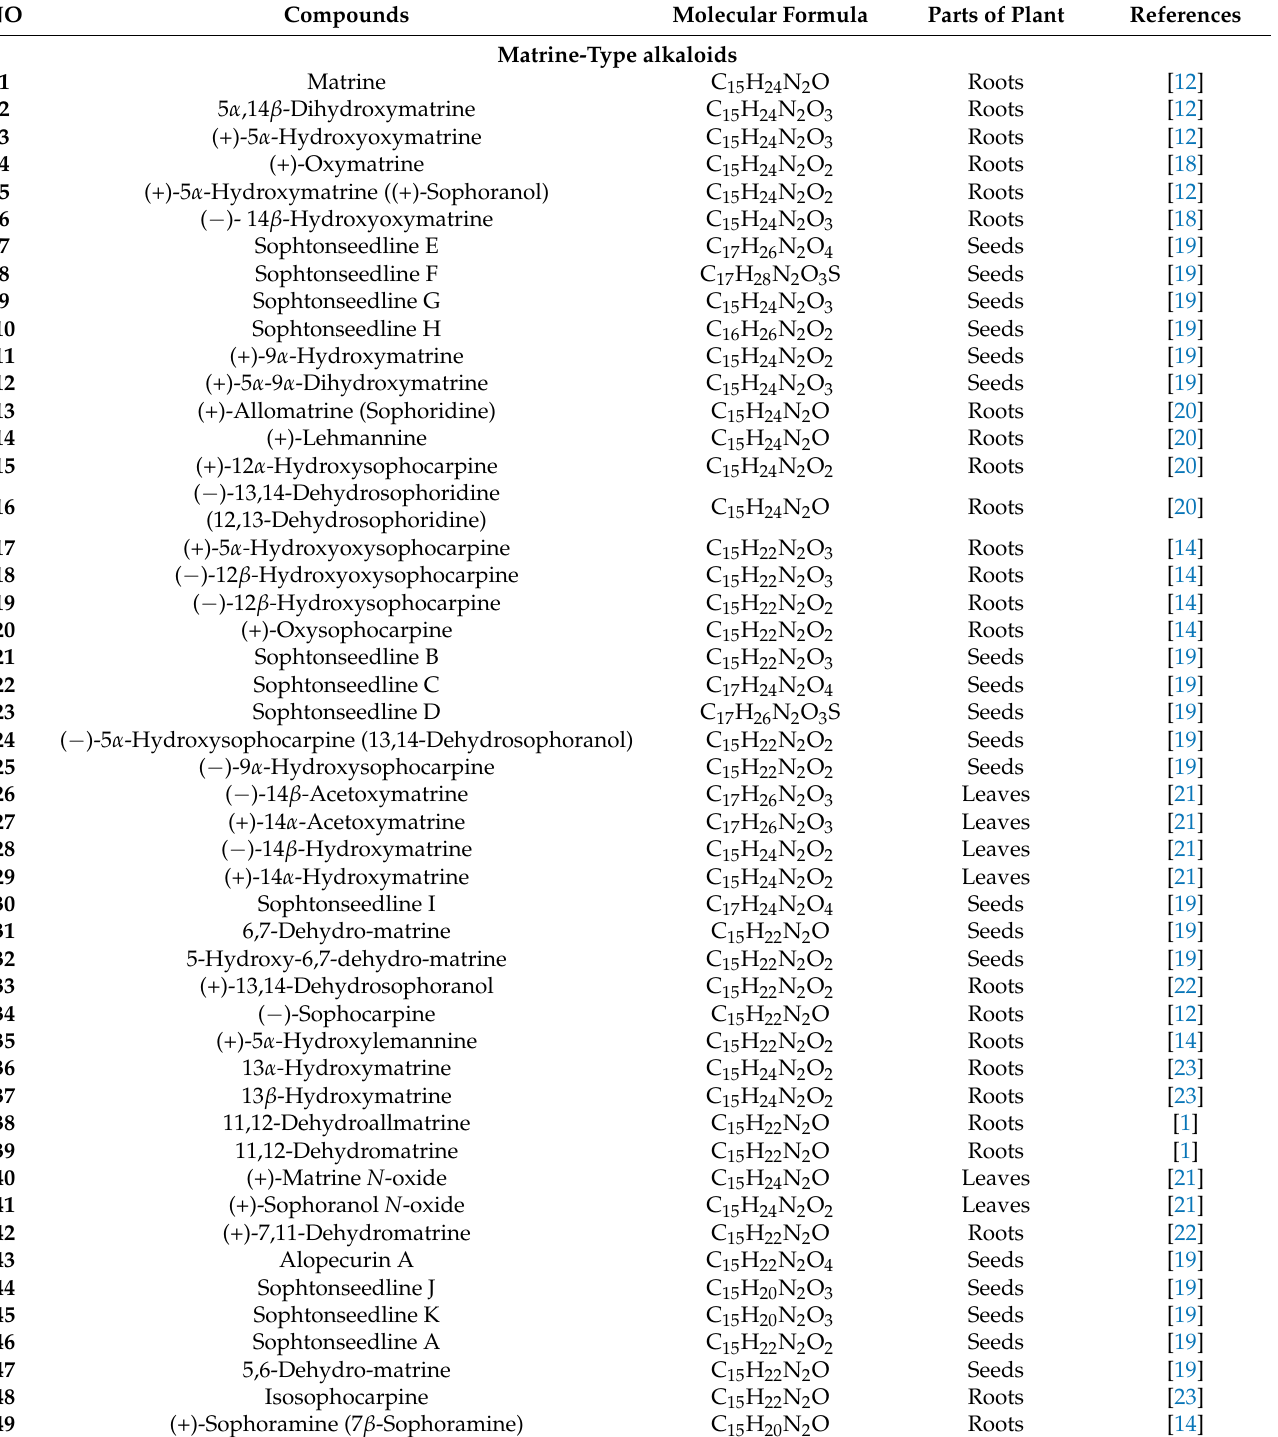
Table 1. The comprehensive list of the compounds from S. tonkinensis and its Endophytic